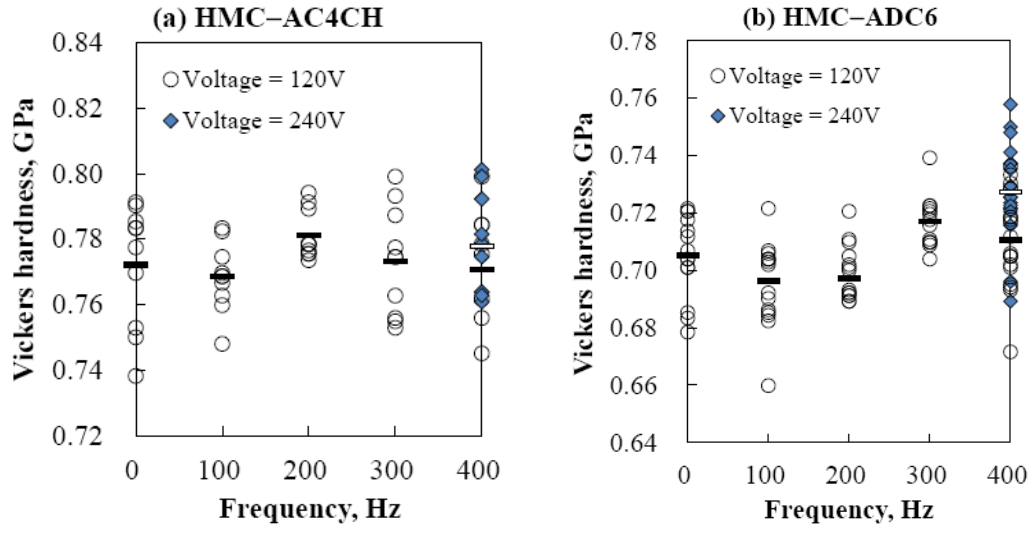
Figure 8. Variation of Vickers hardness as a function of vibration frequency and vibration amplitude of: ( a ) HMC–AC4CH and ( b )